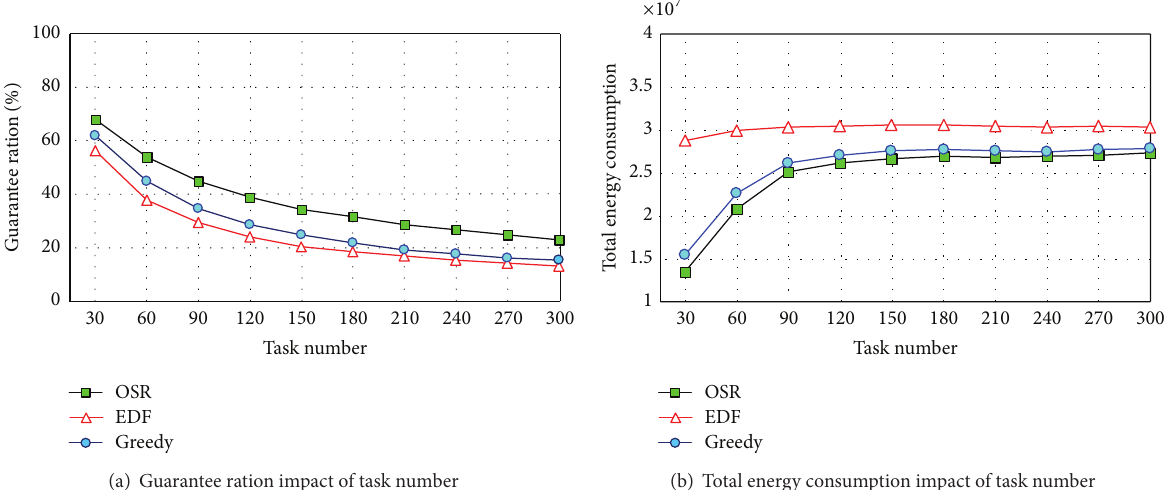
Figure 3: The scheduling results of OSR